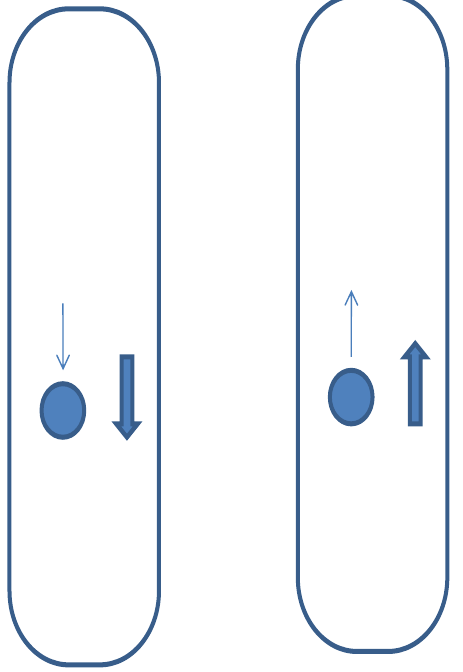
Figure 26. Hydrodynamics for Entrained Flow